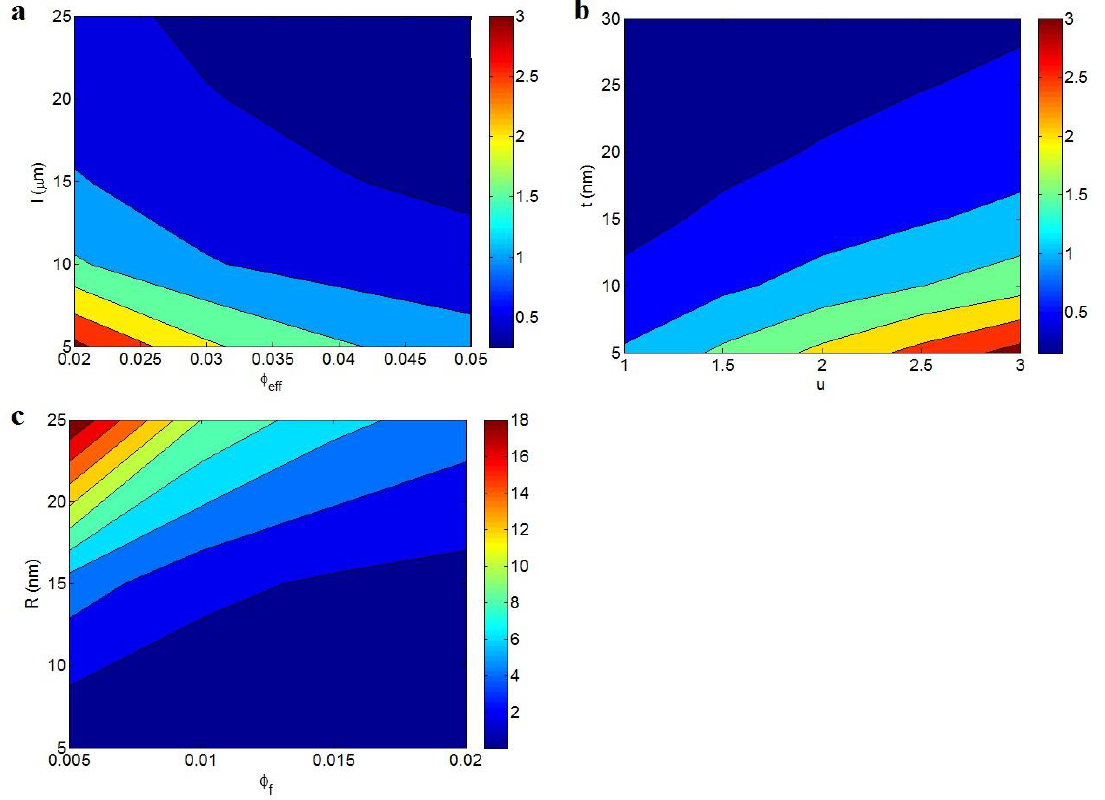
Figure 5. The tunneling distance (Equation (12)) as a function of ( a ) ϕ ef f and l , ( b ) u and t , and ( c ) ϕ f and R parameters.